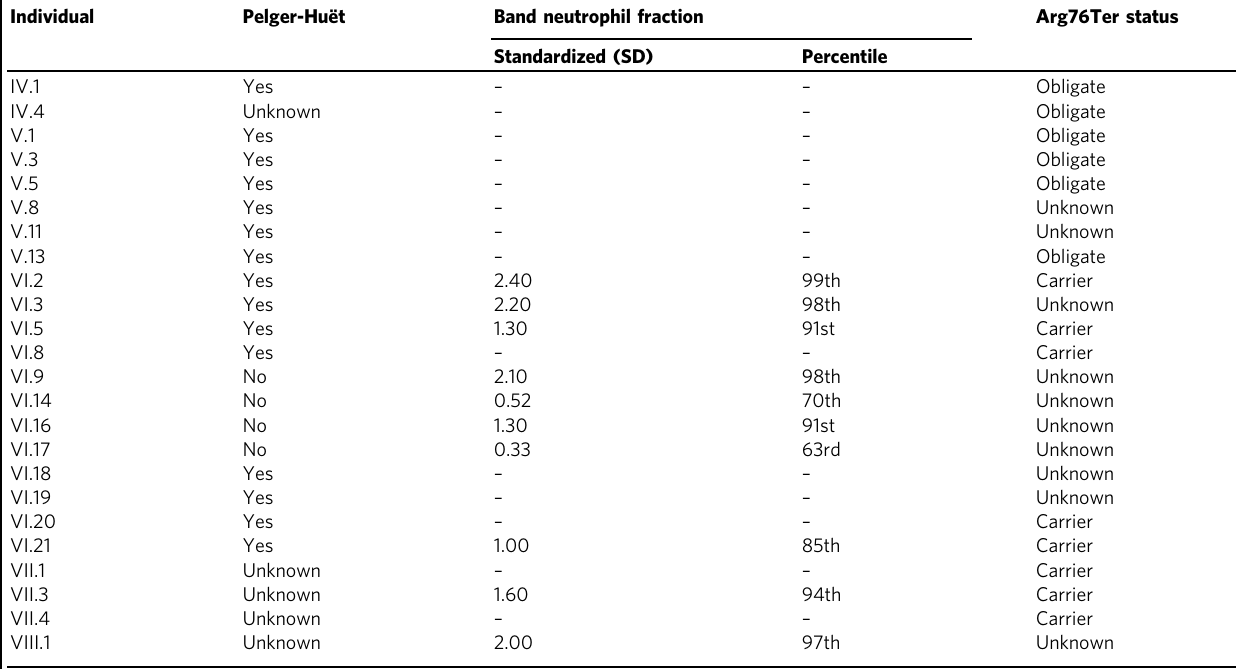
A table of members of an Icelandic family with Pelger-Huët anomaly and their carrier status referring to pedigree shown in Fig. 3. Individual shows the generation in Roman numbers and the individual number in Arabic number, Pelger-Huët diagnosis based on ref. 22 , SD standard